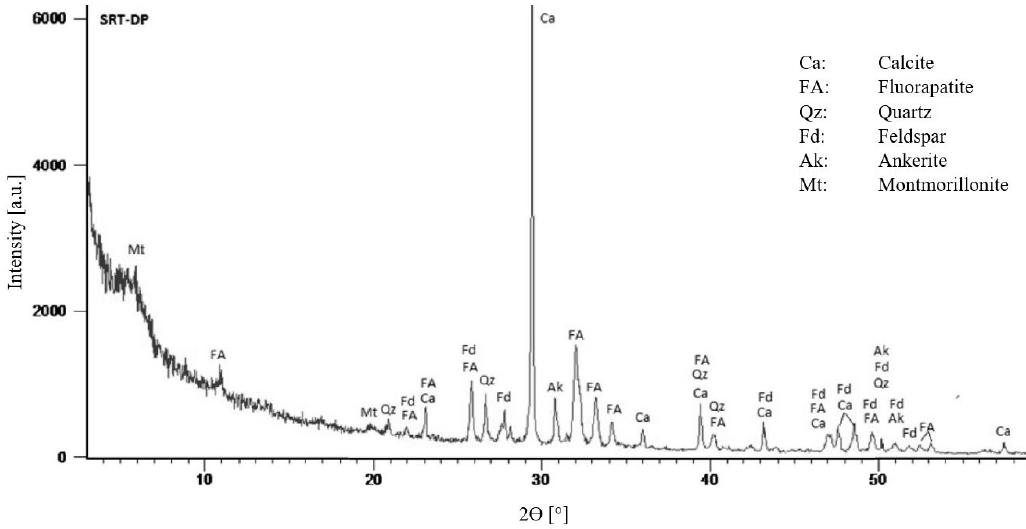
Figure 8. XRD pattern of the untreated Sra Ouertane (layer A1) phosphate rock.